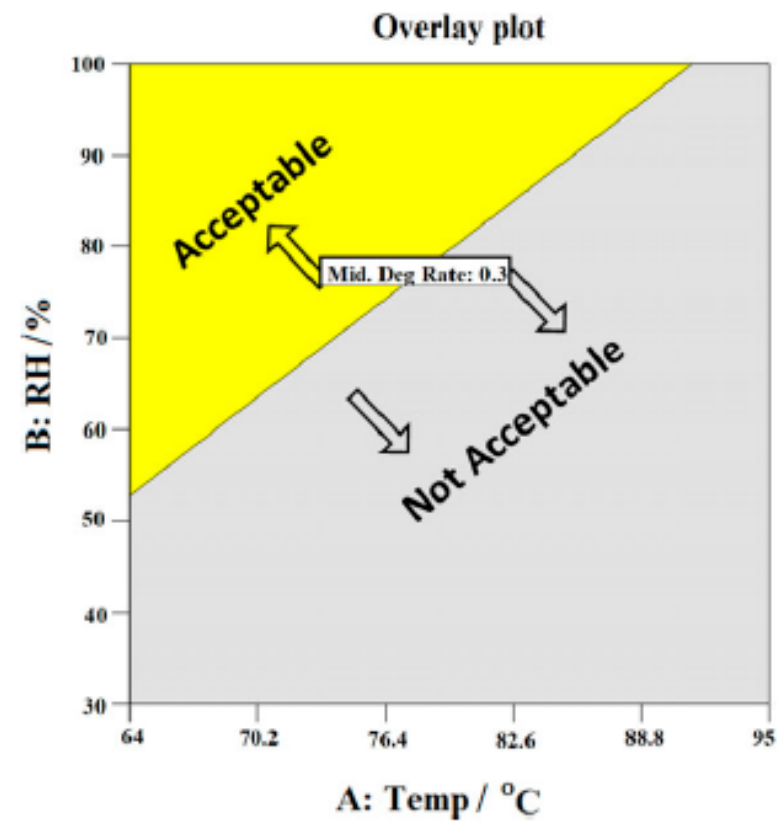
Figure 8. Fuel cell operation area diagram [78].